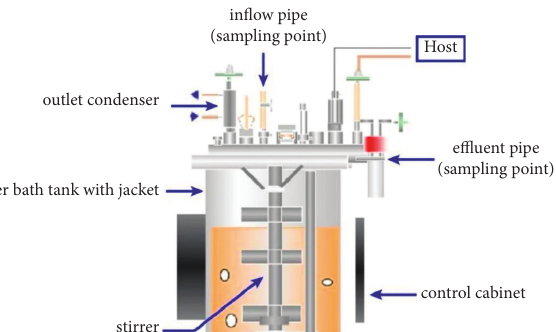
Figure 2: Schematic diagram of the integrated denitrification